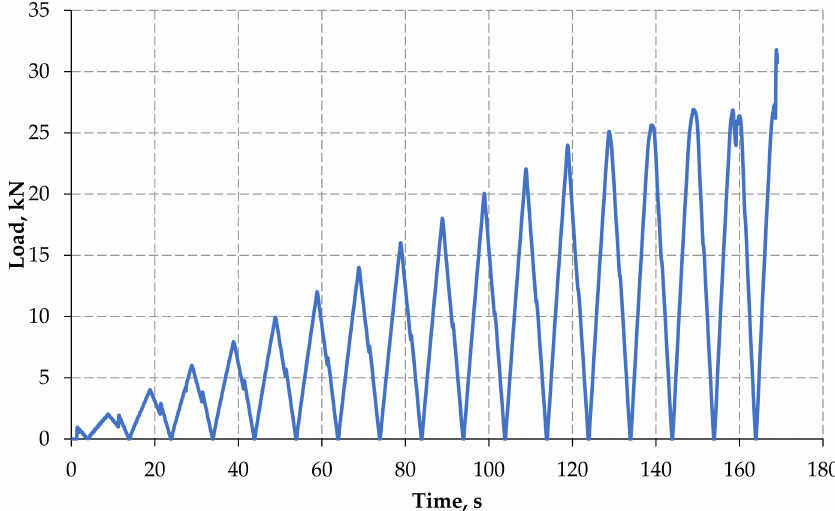
Figure 7. Load history—forward cyclic load.